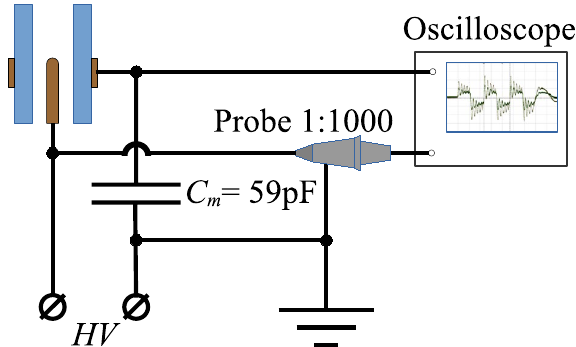
Figure 8. Electrical measurement scheme: HV —applied high-voltage signal; C m —measuring capacitance; Probe 1:1000 is a high-voltage